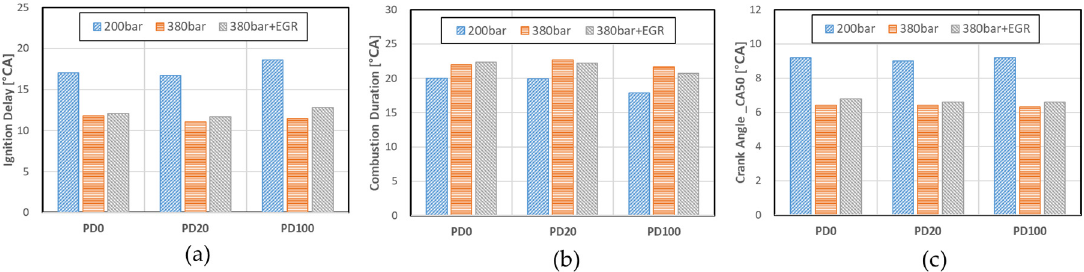
Figure 6. Mass Fraction Burned. ( a ) Ignition delay, ( b ) combustion duration, and ( c ) CA50.